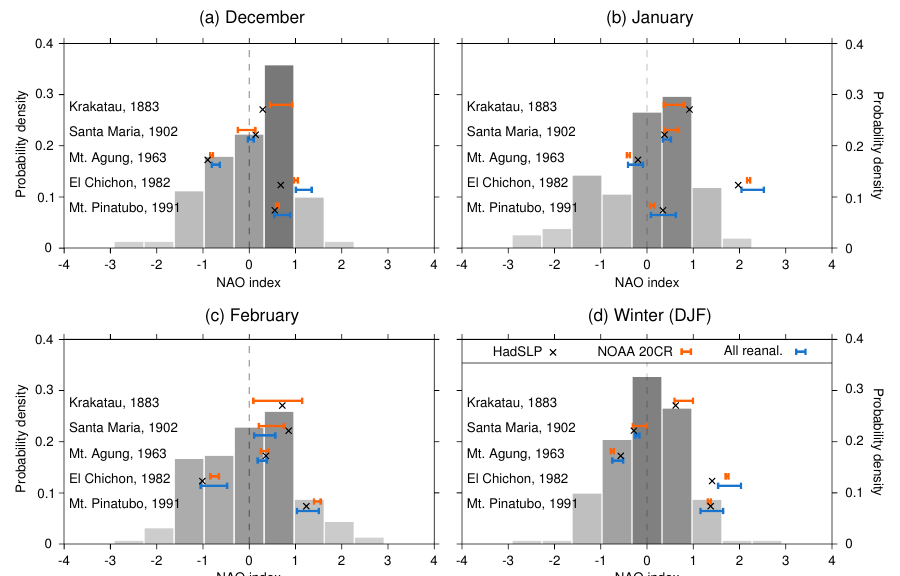
Figure 5. Monthly North Atlantic Oscillation (NAO) index of the first winter after five volcanic eruptions (a–c) and the winter mean (d) , calculated with HadSLP2 observation data and reanalysis data. All data are calculated with respect to the mean for the years 1979–2012, excluding the following 2 years after the two eruption. The EOF is calculated over the period 1979–2012 for every product separately. The histogram shows the NAO index of the 163 years of observation data (1850–2012). Black crosses show the results of the HadSLP2 data. The blue lines show the reanalysis data spread of the NAO index for the winter after all eruptions except Krakatau. The orange lines show the 95% ensemble spread of the NAO after all five volcanic eruptions calculated with the NOAA-20CR dataset.